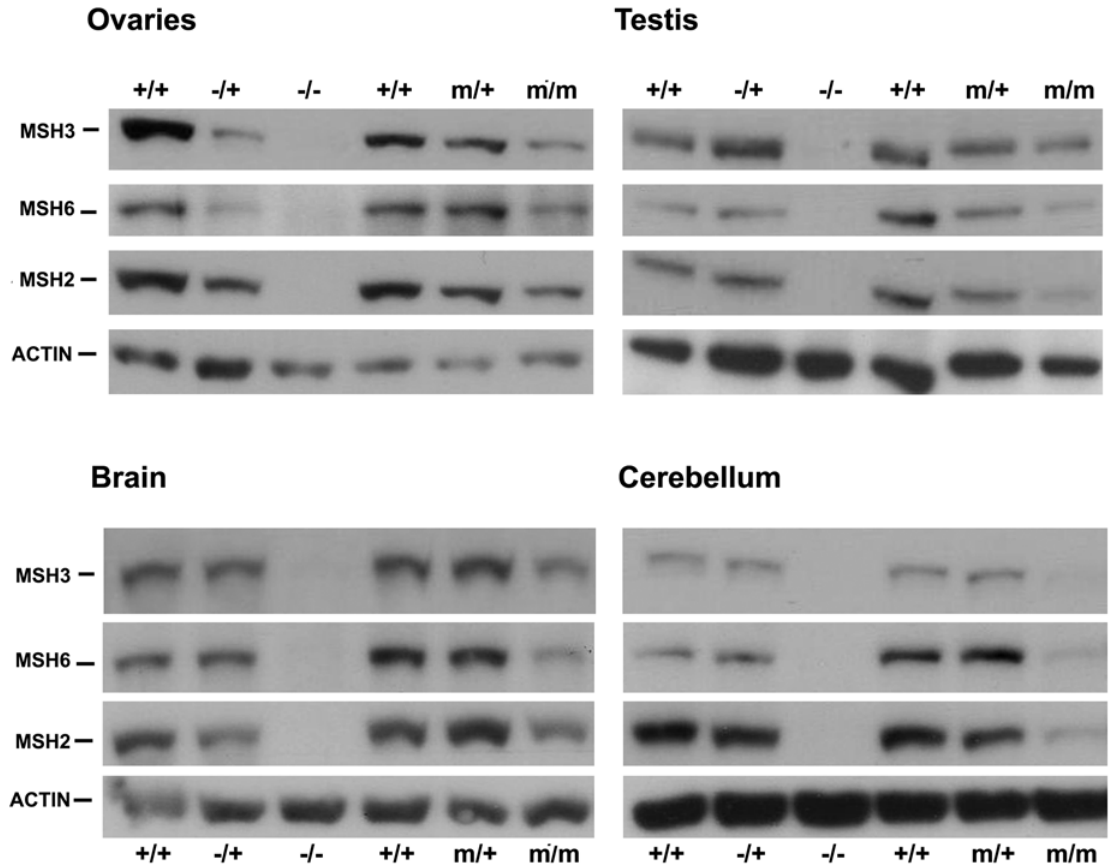
Figure 5. MSH2, MSH3 and MSH6 protein levels in 3 to 4-month-old mice carrying different Msh2 genotypes. Western blot analysis of MSH2, MSH3 and MSH6 protein levels in ovaries, testis, brain and cerebellum from Msh2 + / + , Msh2 2 / + , Msh2 2 / 2 (C57BL/6J, 129/OLA, FVB), Msh2 + / + , Msh2 m/ + and Msh2 m/m ( . 90% C57BL/6J) mice. b -actin was used as a loading control. Each lane represents pooled protein extracts from three mice. MSH2: 104 kDa, MSH3: 123 kDa, MSH6: 160kDa and b -actin: 6